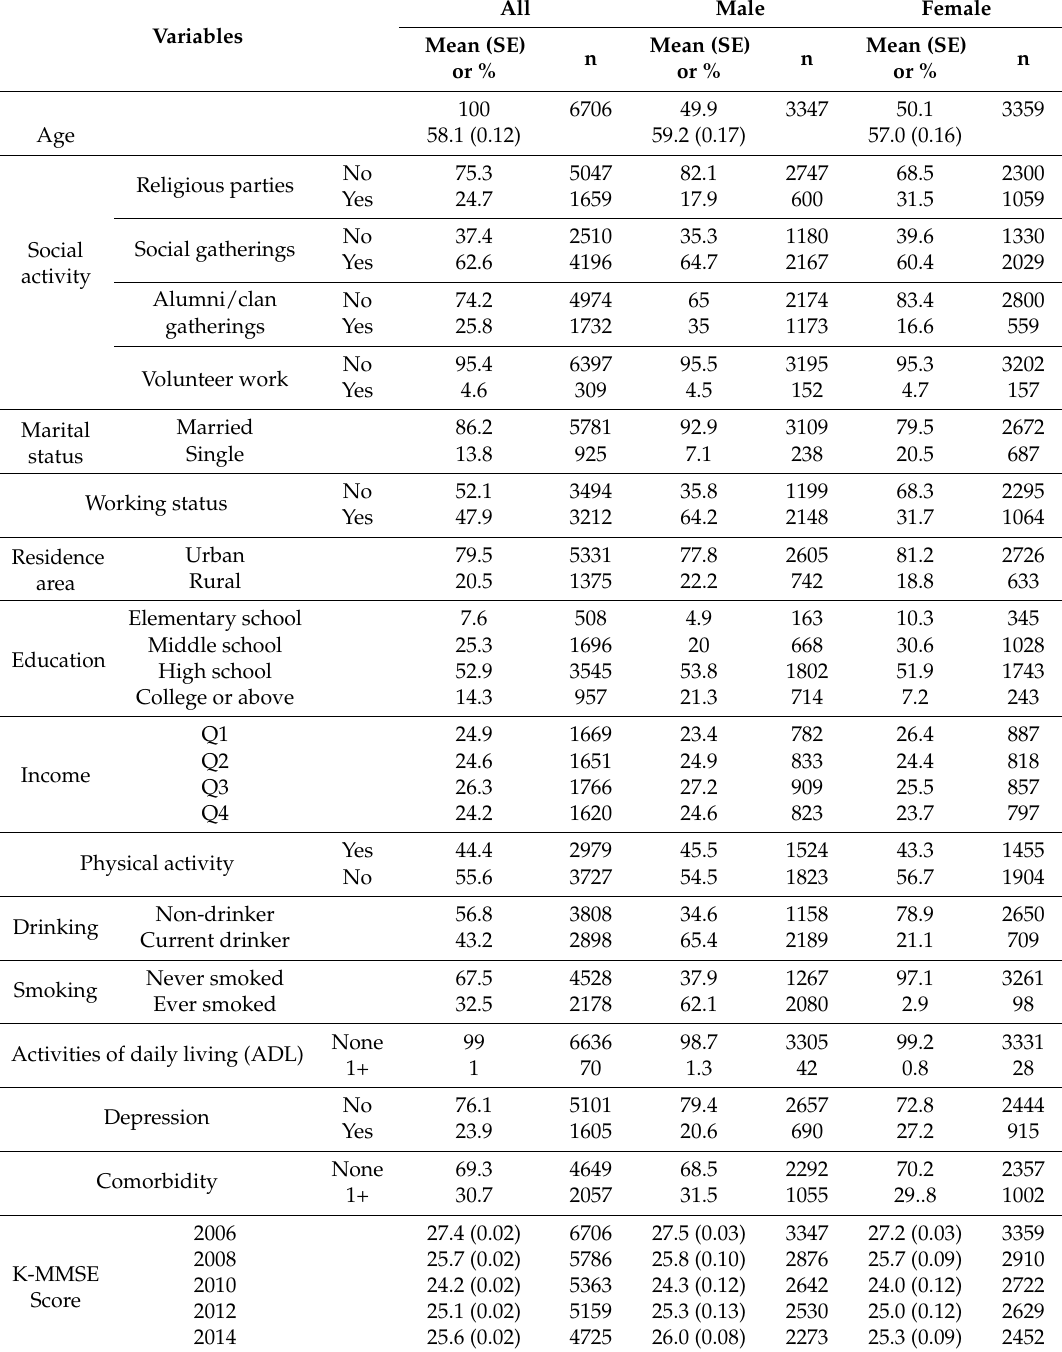
Table 1. Descriptive characteristics of the sample from the Korean Longitudinal Study of Aging